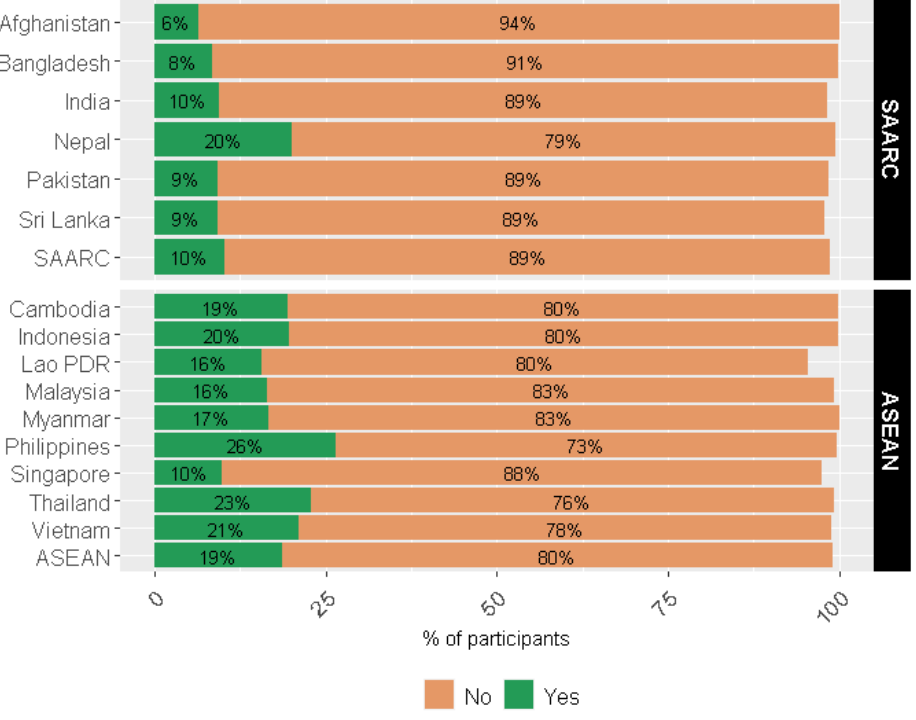
Figure 6. Percentage of participants who saved money for starting or operating a business.